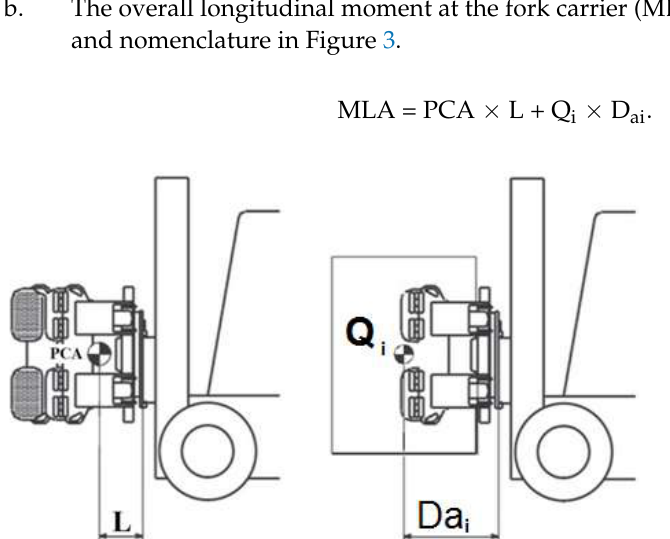
Figure 3. Evaluation of MLA: nomenclature. Key: PCA—total mass of the interchangeable equipment; L—distance measured horizontally from the fork carrier to the centre of gravity of the unladen interchangeable equipment; Da i — distance measured horizontally from the fork carrier to the centre of gravity of the load; Q i — maximum load permitted by the manufacturer at Da i .